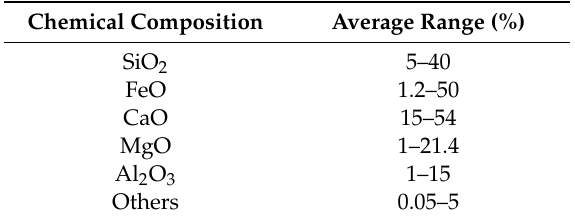
Table 1. Chemical composition of electric arc furnace (EAF) slags (wt. %) values averaged from [2] by literature